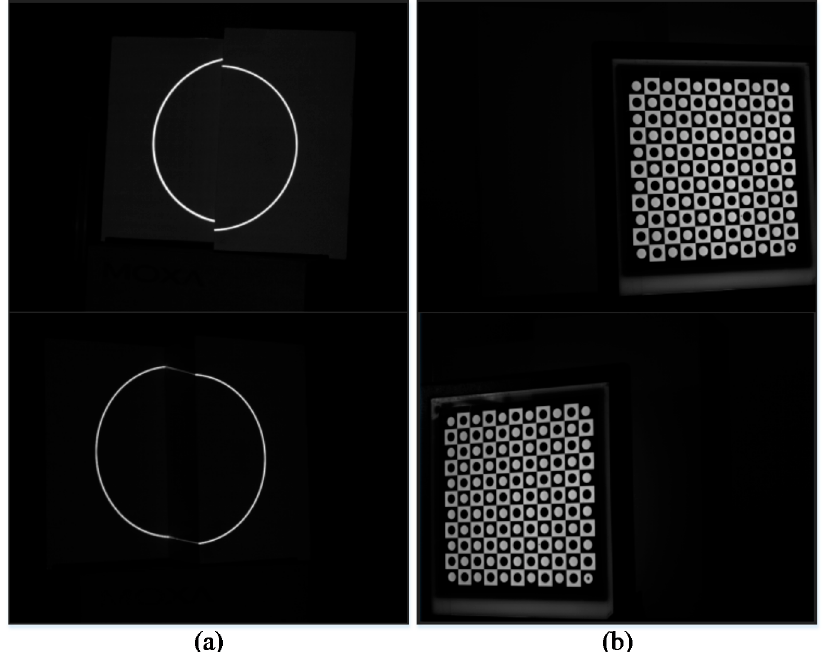
Figure 13. Images used in calibration via two methods. ( a ) Images used in calibration via the proposed method; ( b ) Images used in calibration via Zhang’s method.